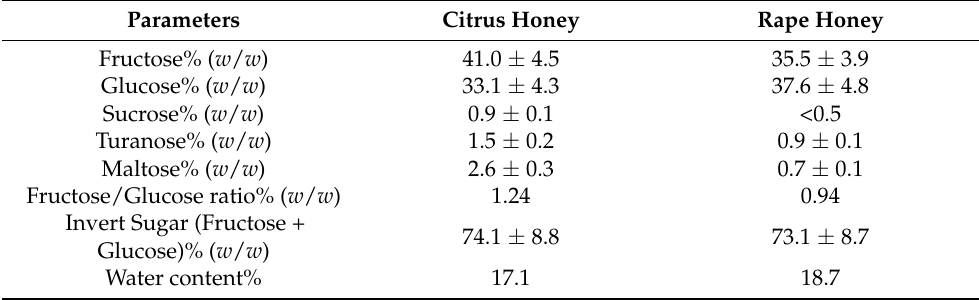
Table 1. Honeys’ analysis. Determination of saccharides content (fructose, glucose, sucrose, turanose, and maltose) through HPLC method (DIN 10758:1997-05) and water content. Expanded uncertainty is expressed with a coverage factor of two and a confidence limit of